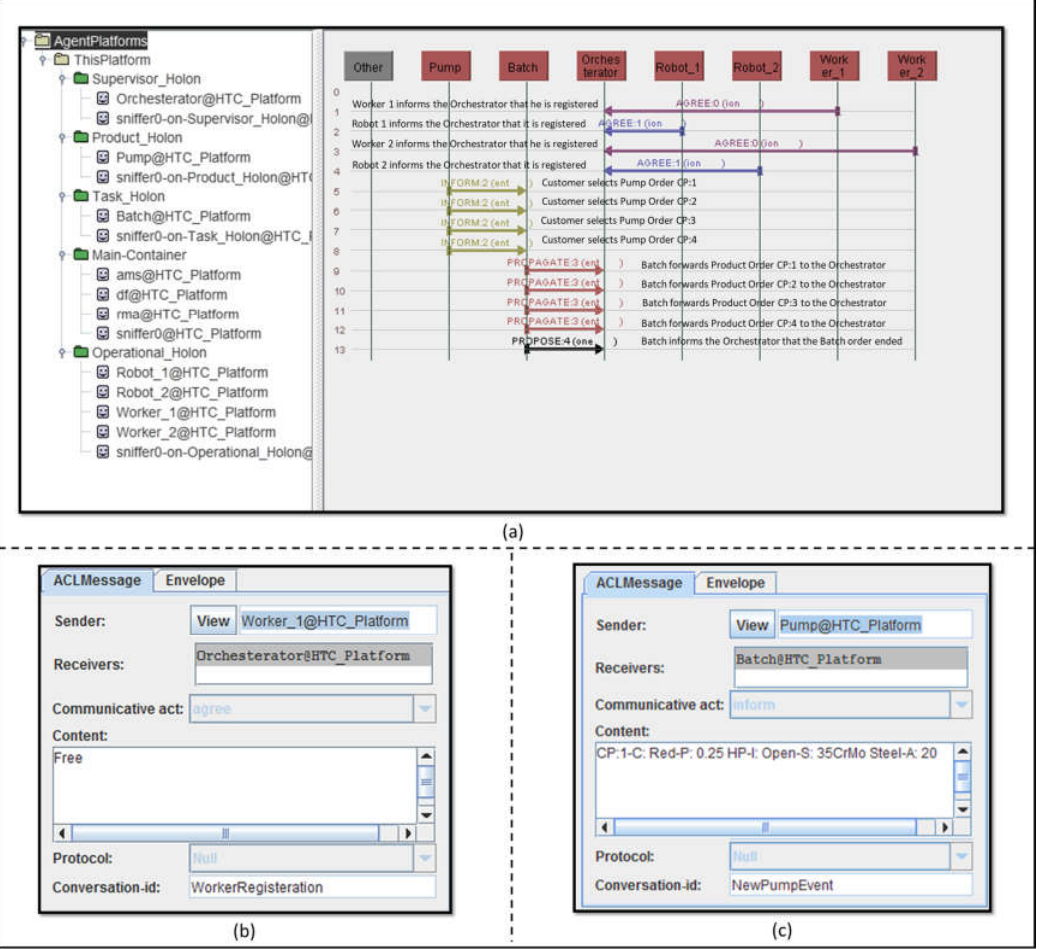
Figure 10 . ( a ) Workcell Setup and Batch Order Building; ( b ) ACL Message holds the Worker Registration; ( c ) ACL Message holds the product details.